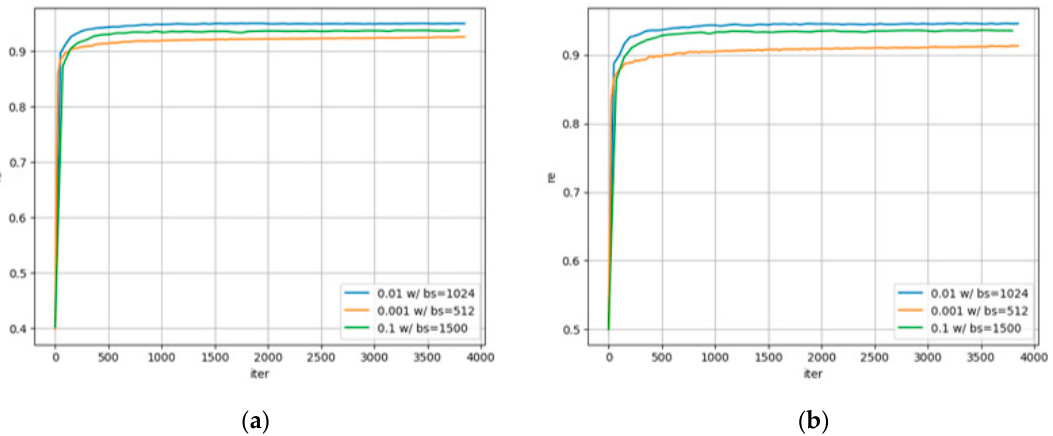
Figure 6. ( a ) F1 score at different learning rate and batch size on the training set. ( b ) Recall at different learning rate and batch size on the training set.